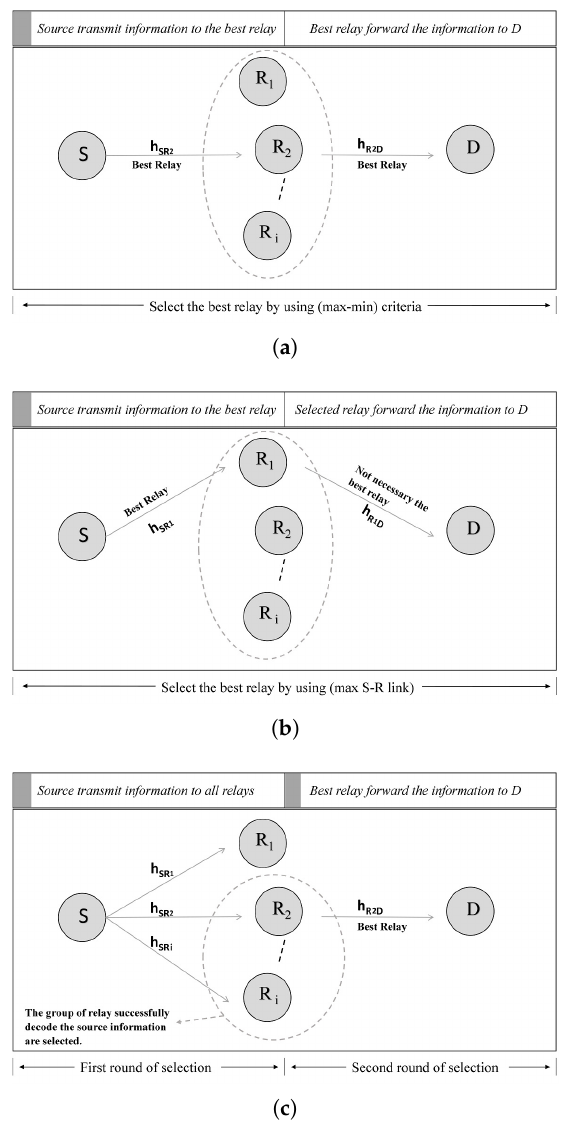
Figure 3. A dual-hop half-duplex decode and forward relay selection schemes. The grey shaded band shows when relay selection occurs. ( a ) Opportunistic Relay Selection(ORS) scheme [11,25,26]; ( b ) Partial Relay Selection (PRS) scheme [11,25,26]; ( c ) The proposed Two-Round Relay Selection (2-RRS)